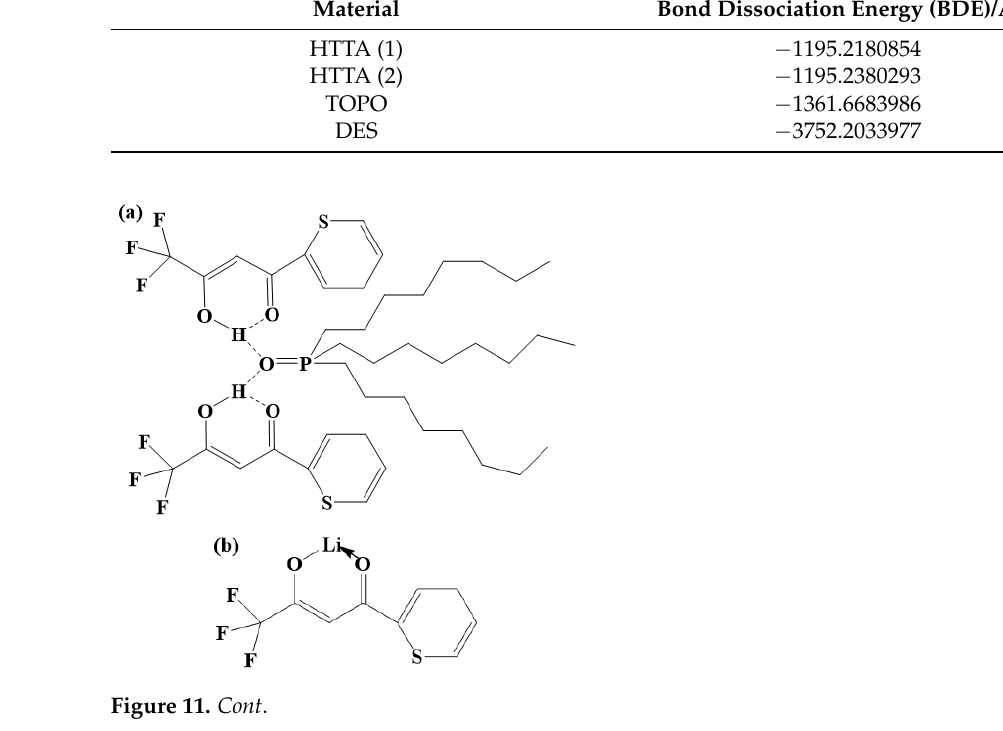
Table 2. Bond dissociation energy of material. HTTA (1) means no intramolecular hydrogen bond is formed, and HTTA (2) means intramolecular hydrogen bonds are formed.